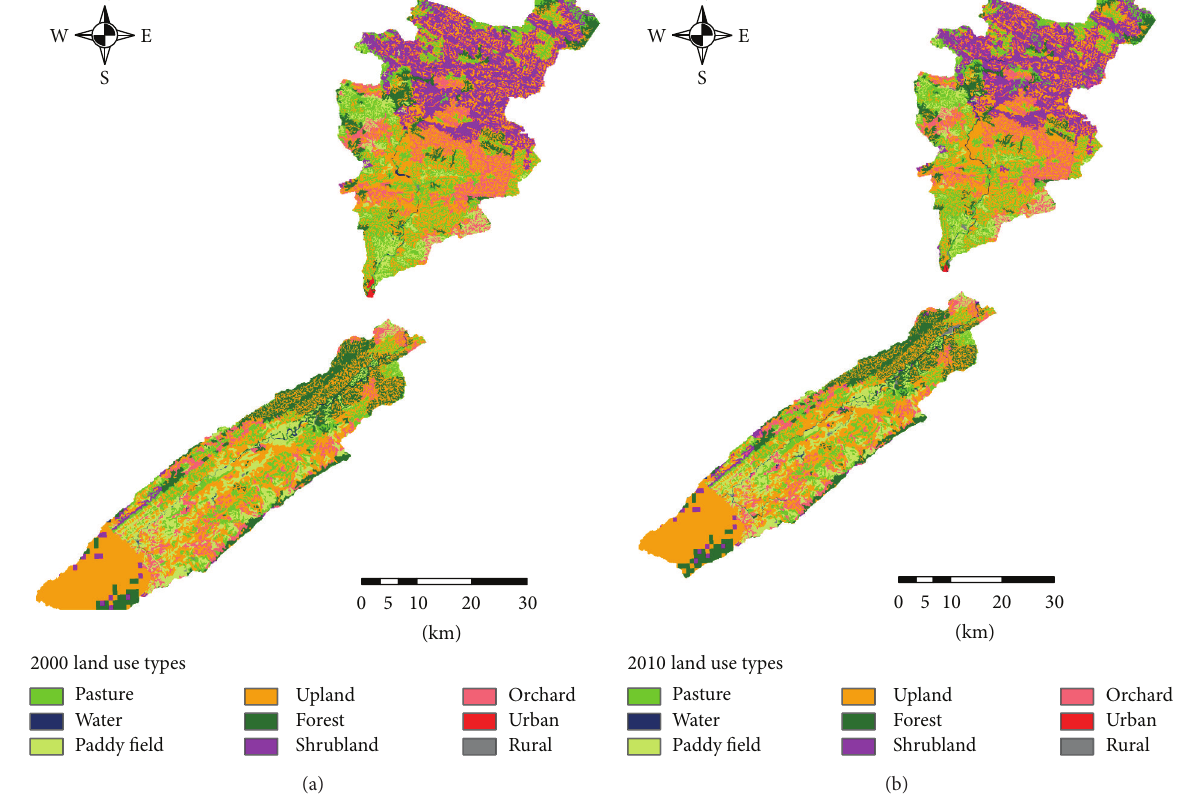
Figure 2: Land use maps of the Pengxi River basin in (a) 2000 and (b) 2010.